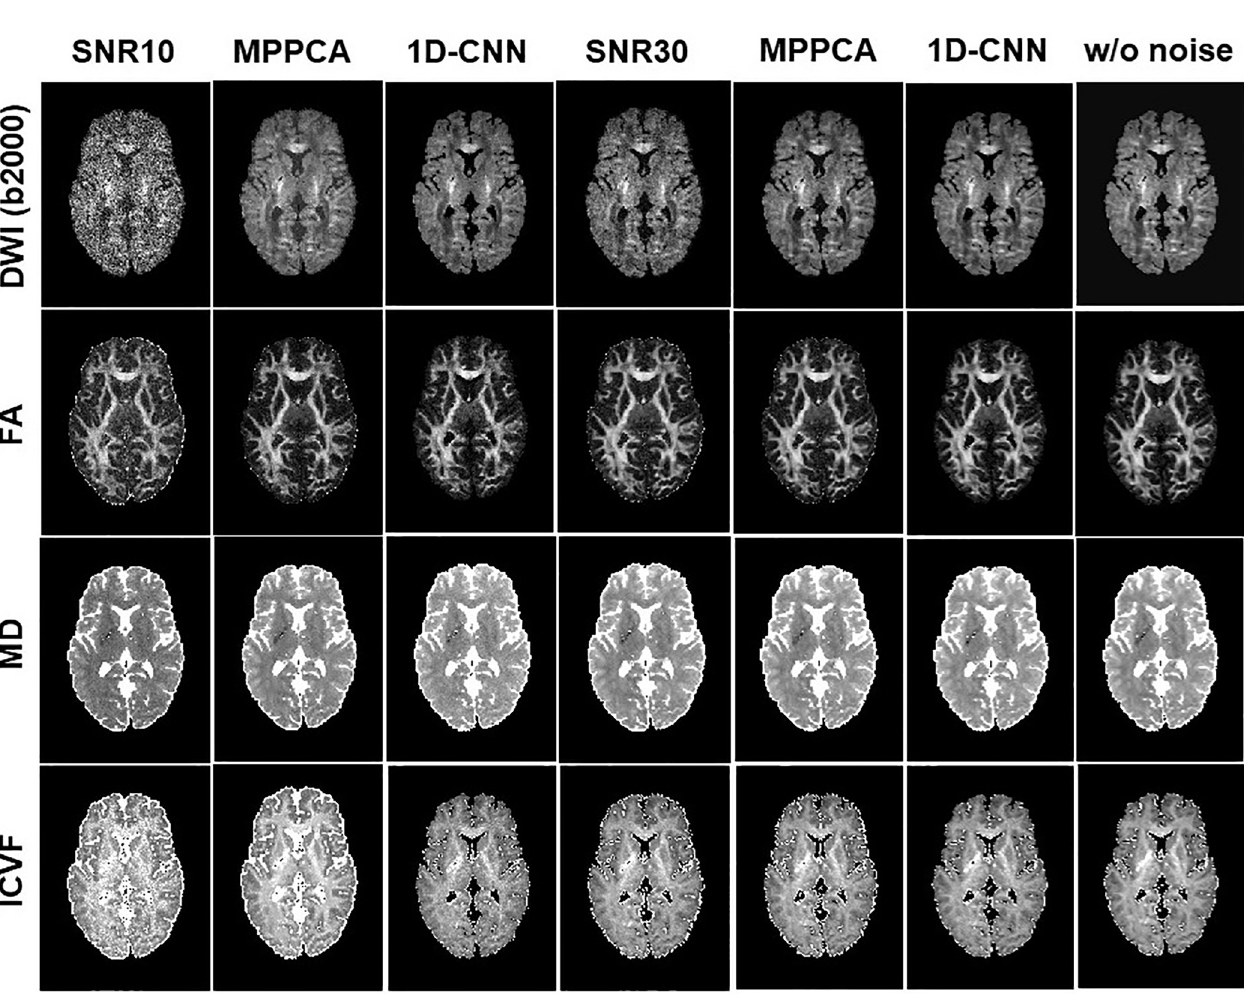
Fig 4. The noisy DWI images (SNR 10 and 30), corresponding denoised images with MP-PCA and 1D-CNN, and the ground truth, along with derived FA, MD, and ICVF maps of a representative slice from